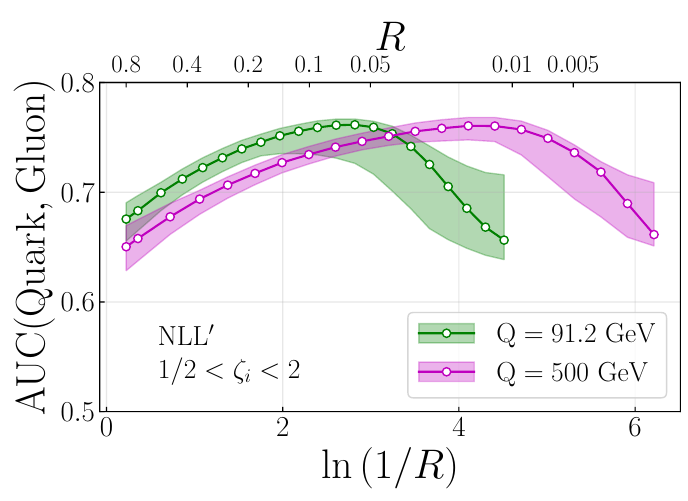
Figure 15 . Quark/gluon discrimination power of leading (sub)jets (AUC) as a function of the jet radius R and two different values of the energy scale Q